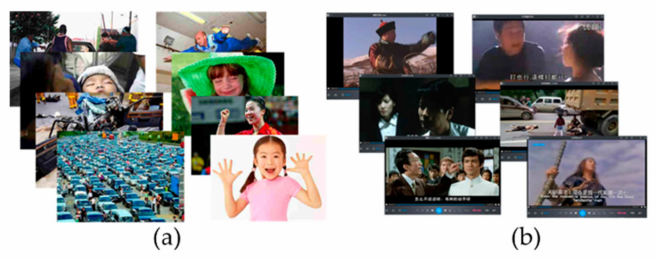
Figure 8. Some emotion induction materials. ( a ) Pictures; ( b ) Movie clips.